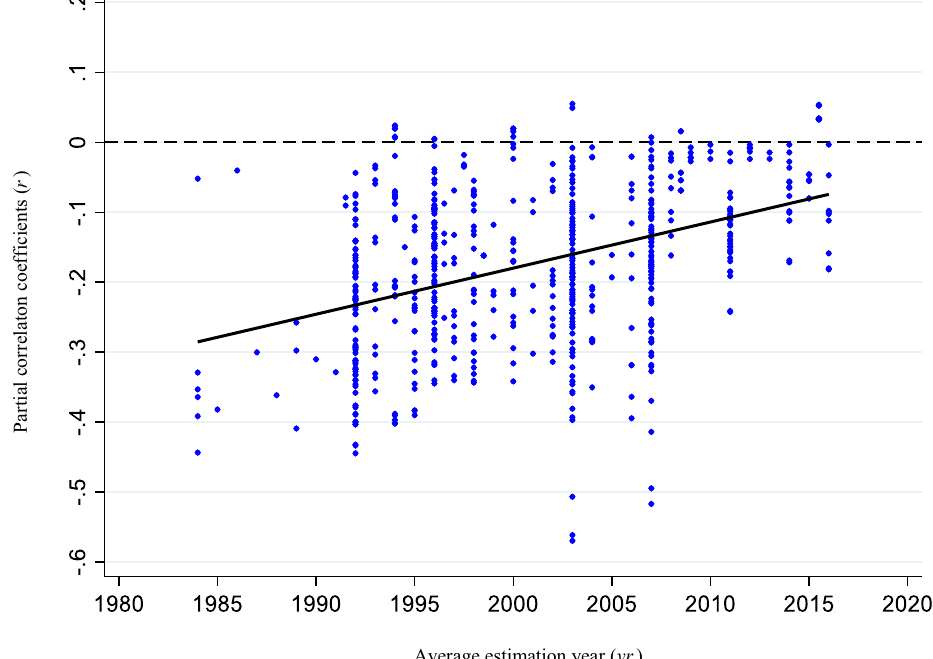
Fig. 3 Chronological order of partial correlation coefficients. This figure shows the chronological order of partial correlation coefficients of estimates of the gender dummy variable reported in 53 research works listed in Additional file 1: Table S1 and Additional file 2: Bibliography of studies subject to meta-analysis. See Table 1 for the descriptive statistics of estimates. The solid black line in the figure displays the fit line. The equation of the fit line is described below. The values in parentheses below the coefficients in the equation are robustness standard errors. *** denotes statistical significance at the 1% level. r -13.3680(1.1291) *** 0.0066(0.0006) *** yr . Adj. R 2 0.1685 F 136.55 = + = =